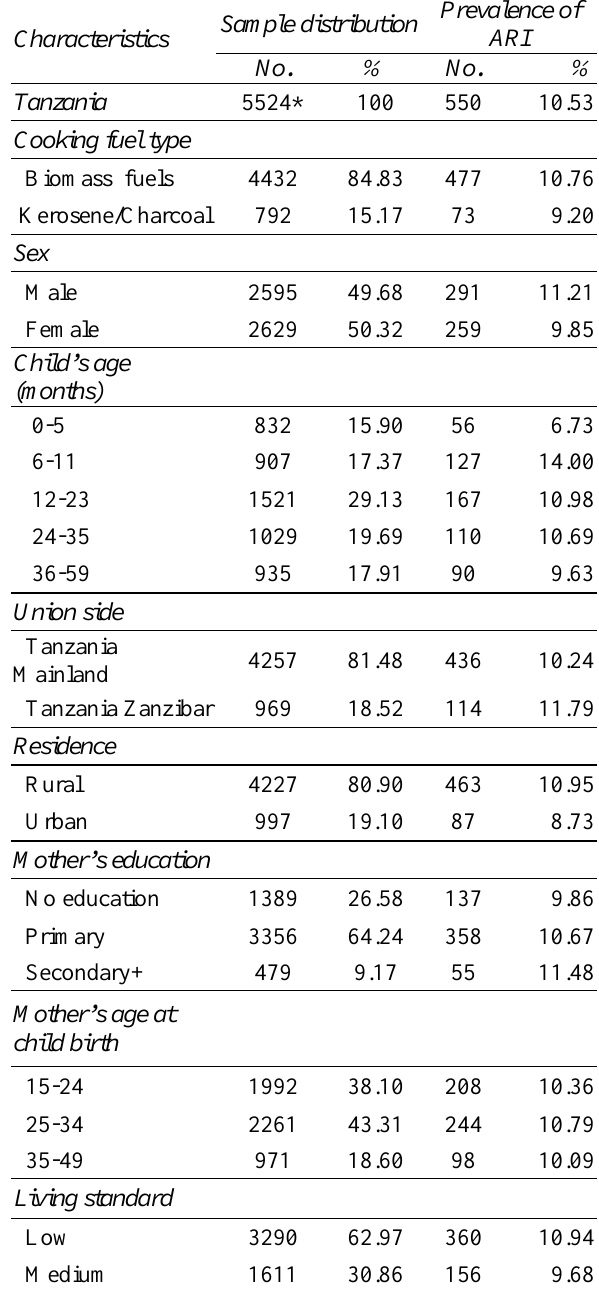
Table 1: Sample distribution and ARI prevalence in children under 5 years old two weeks prior to TDHS